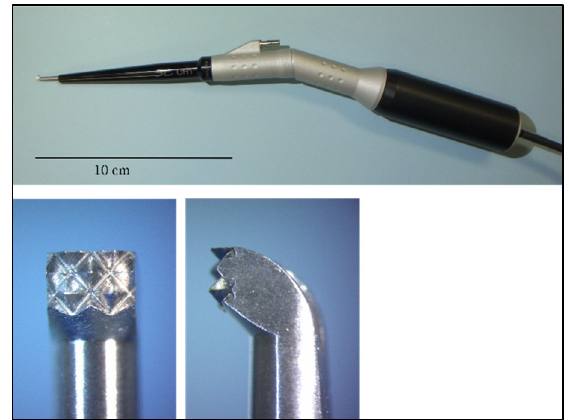
Figure 1. Ultrasonic bone curette handpiece (top photo) and the bone tip (bottom two photos). The width of the tip is 2 mm.